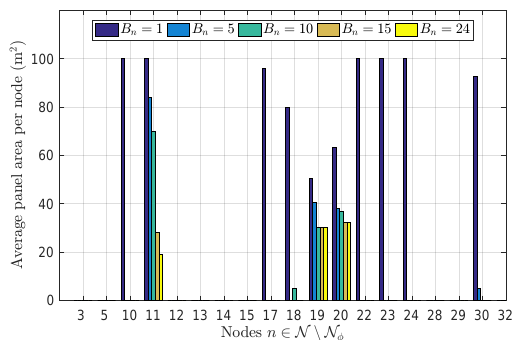
Figure 8. Average panel area per node.